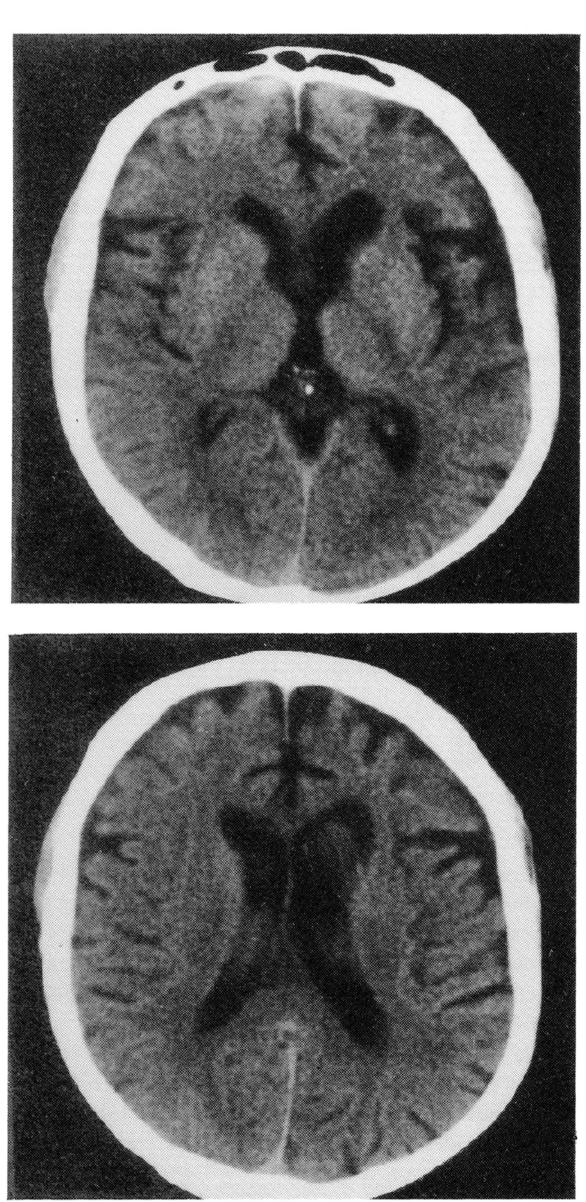
FIG. 1. CT scans: cortical atrophy and ventricular dilatation, more marked on the left